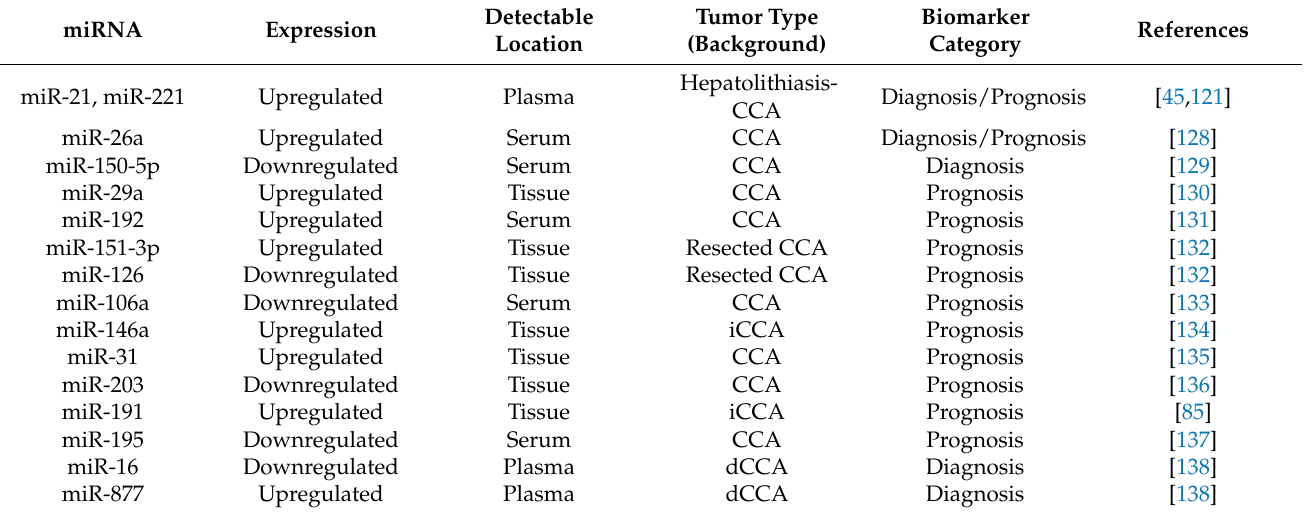
Table 3. The expression levels of potential miRNA-based biomarkers in cholangiocarcinoma. miRNA